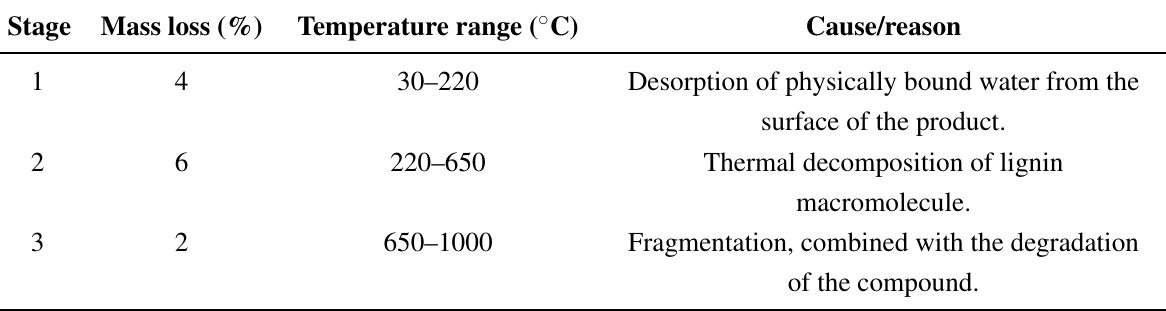
Table 2. Three characteristic stage of weight loss for silica–lignin hybrid